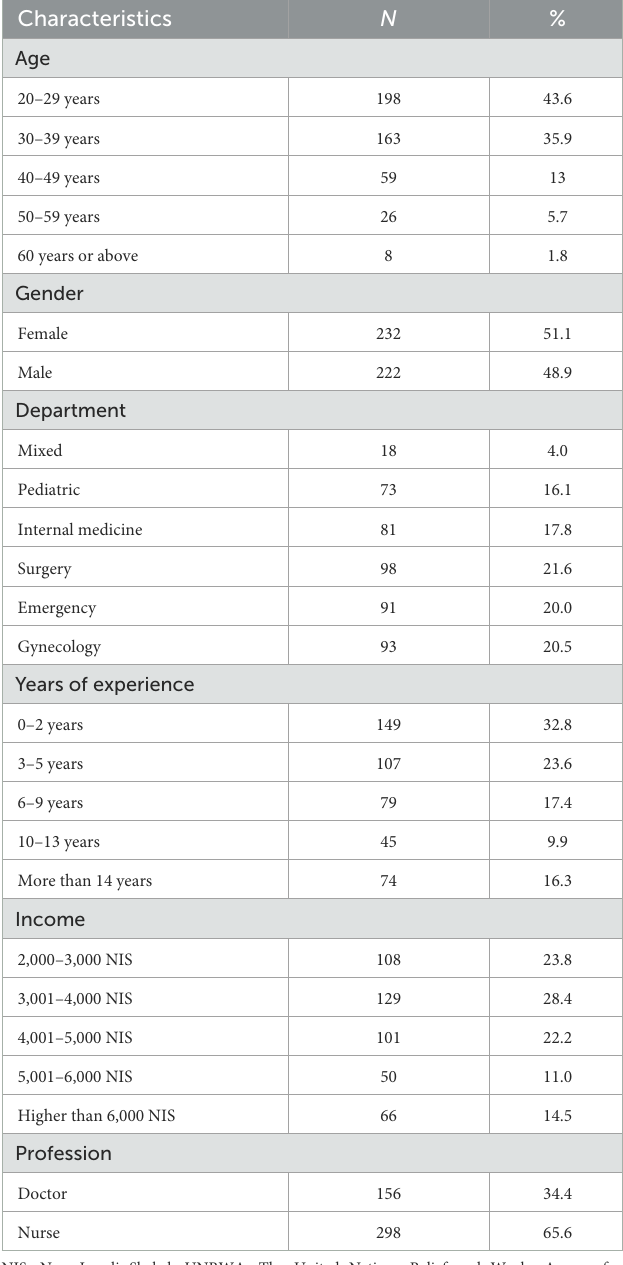
TABLE 1 Sociodemographic characteristics of HCWs (N =